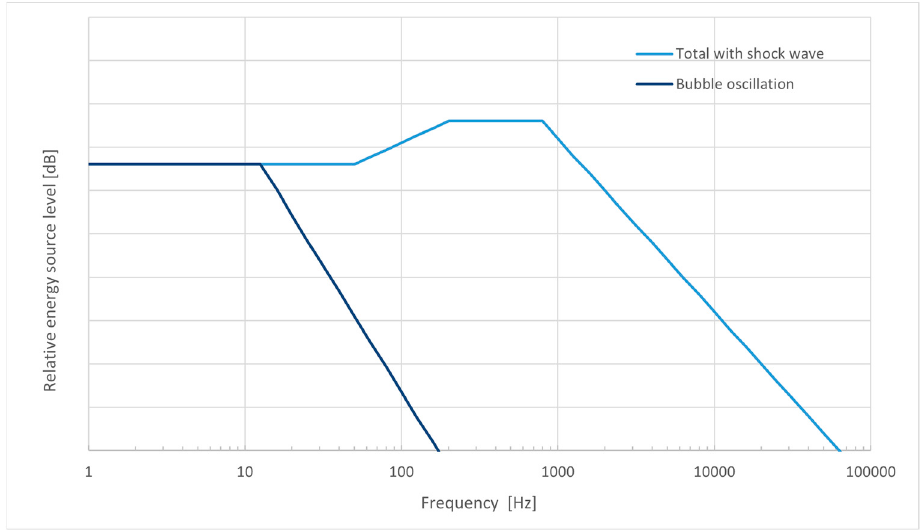
Figure 8. Idealistic frequency distributions assumed for the description of the shock wave and the pressure wave of an explosion event.